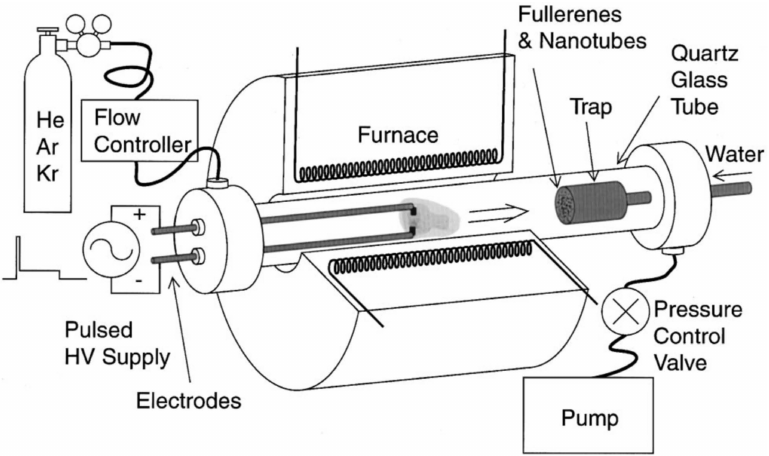
Figure 1. Schematic of a high-temperature pulsed arc discharge setup. Reprinted with permission from Ref. [12]. Copyright 2000, American Chemical